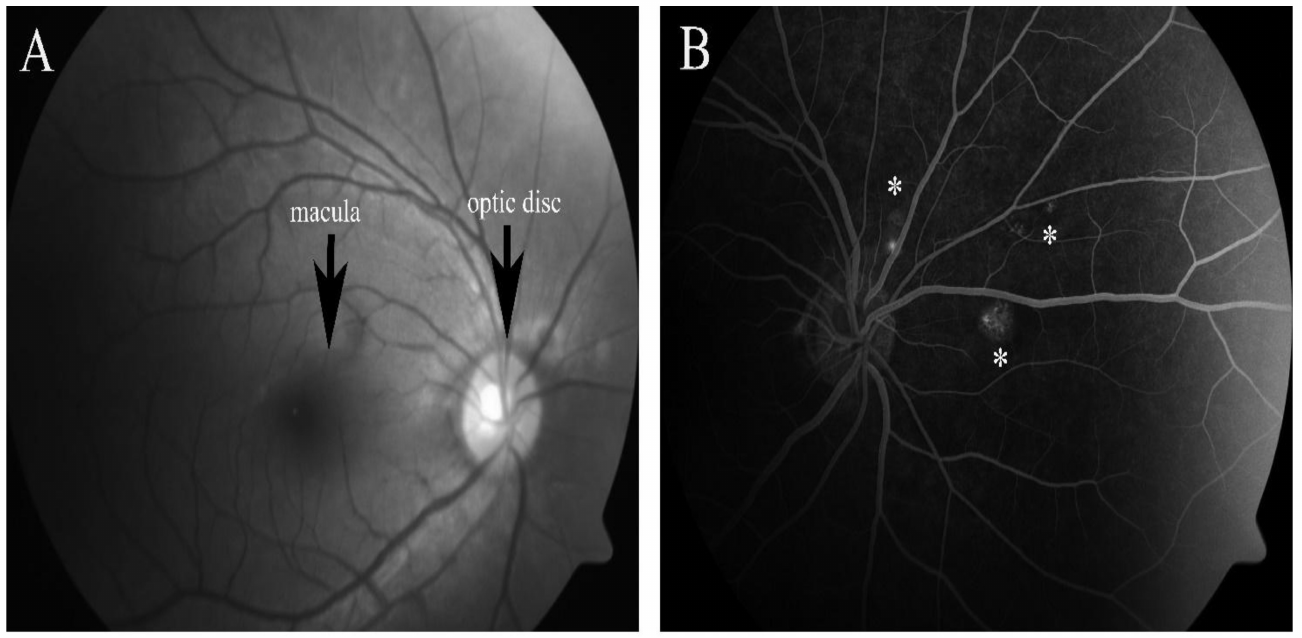
Figure 2. Representative fundus image: ( A ) Normal; ( B ) Wet age-related macular degeneration (AMD). Asterisk indicates drusen, which are lipid-containing aggregations found in the retinal pigment epithelium (RPE)/Bruch’s membrane (BrM) complex. (Original image from Kah-Hui